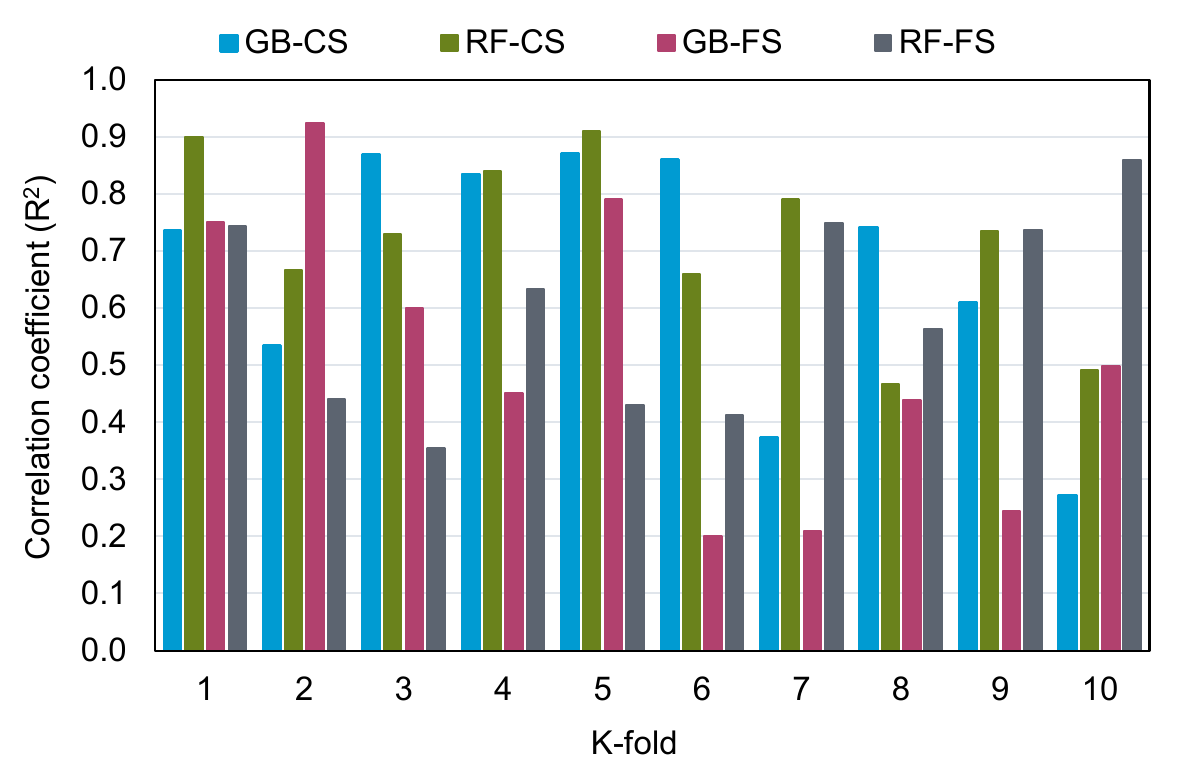
Figure 13. Correlation coefficient (R 2 ) distribution from the k-fold analysis. GB: gradient boosting, RF: random forest, CS: compressive strength, FS: flexural strength.